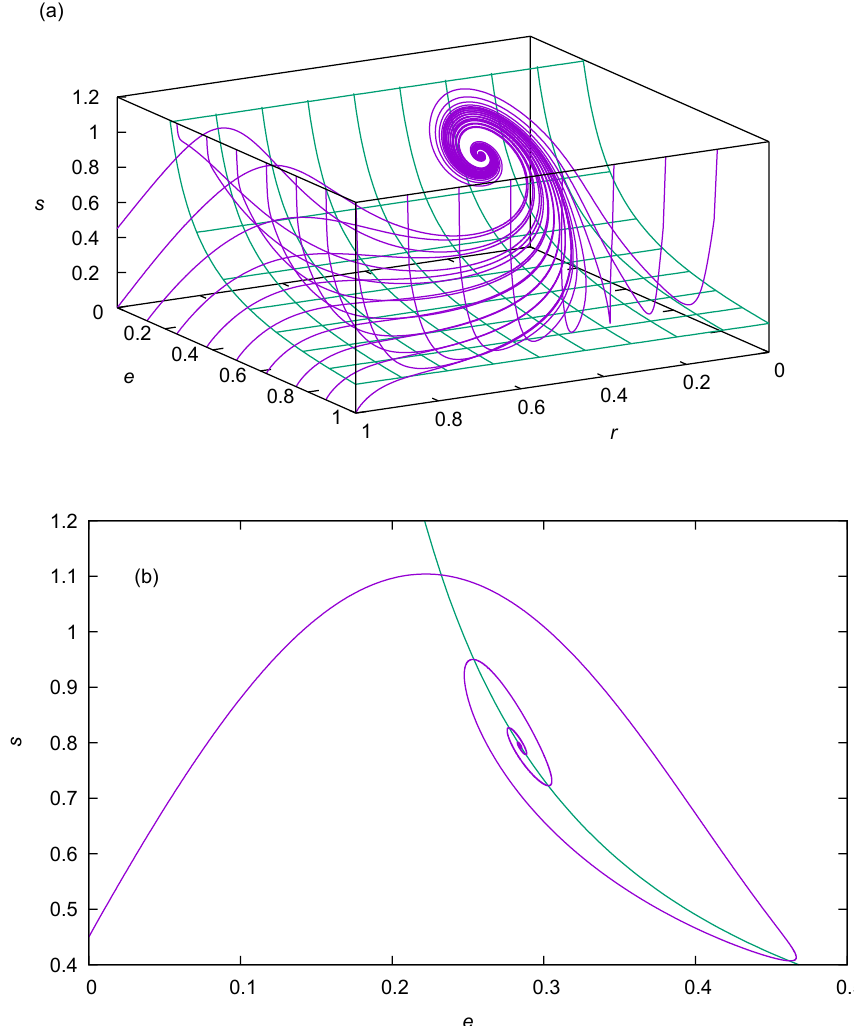
Figure 1. Trajectories of the ordinary differential equation (ODE) system (11) for ε 1 = 0.01, ε 2 = 1, α = 1, β = 1, γ = 1.5, κ = 0.05, n = 4, along with the singular limit of the slow manifold s 0 ( r , e ) (Equation (14b)). ( a ) Several trajectories along with s 0 ( r , e ) in an r × e × s projection. ( b ) A trajectory (oscillating) shown with s 0 ( r , e ) in an e × s